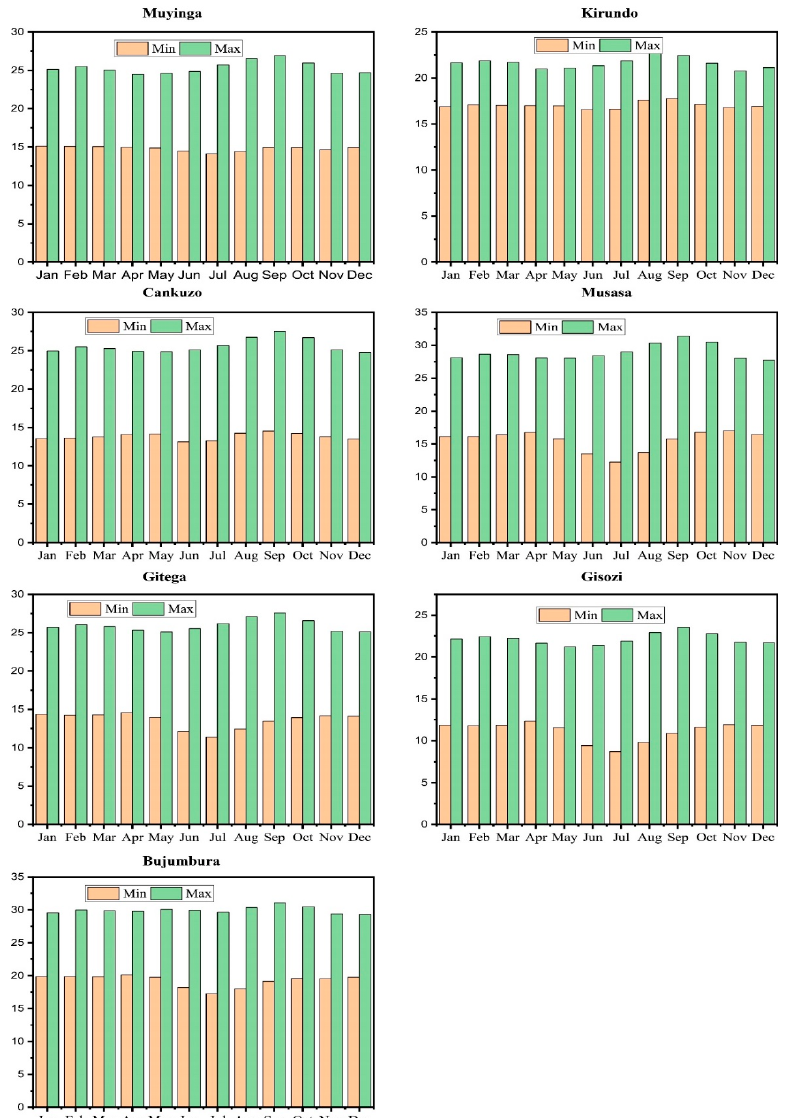
Figure 4. Maximum and minimum monthly mean temperature in o C for meteorological stations of Miyinga, Kirundo, Cankuzo, Musasa, Gitega, Gisozi, and Bujumbura across Burundi.